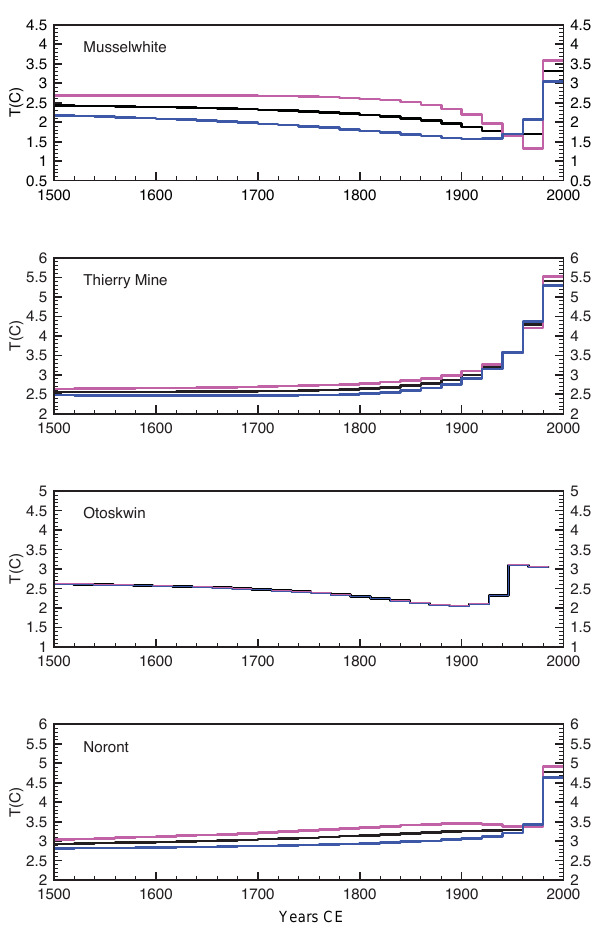
Figure 4. GST histories for the northern Ontario sites determined by inversion of the anomalies. For multiple holes at a given site (Thierry mine and Noront), simultaneous inversion was used. The pink and blue lines represent the inversions of the upper and lower bounds of the anomaly. For Otoskwin, the three lines are super- posed.